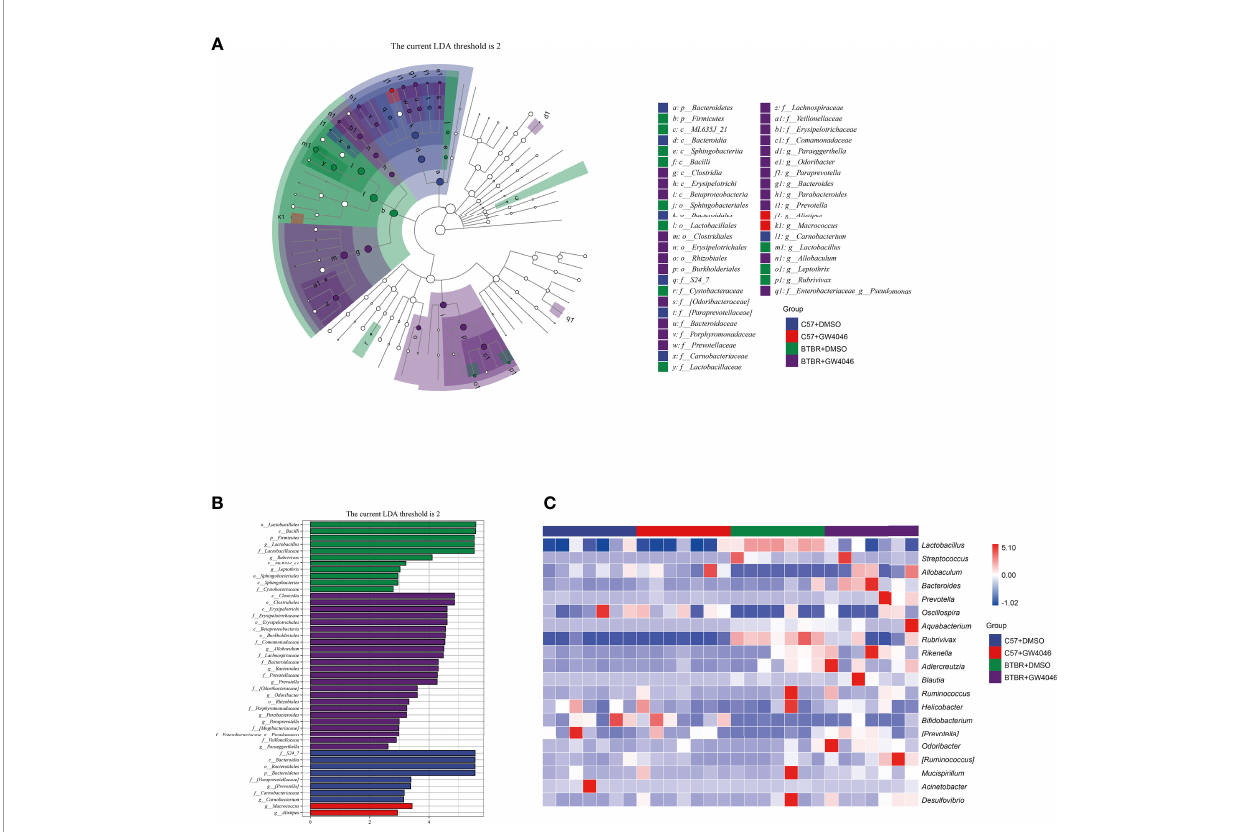
FIGURE 6 | Differential taxa abundance in the gut microbiota. (A) LEfSe analysis of gut microbiota in mice, depicting the taxonomic association between microbiota communities among the four groups. Each node represents a speci fi c taxonomic type. White nodes denote the taxonomic features that are not signi fi cantly differentiated. Blue, red, green, and purple nodes respectively denote the taxonomic types with more abundance than in other groups. The larger the diameter of the nodes, the more signi fi cant the difference. (B) The histogram of LDA value distribution and the evolutionary branch diagram of LEfSe analysis show the species whose LDA Score is higher than the set value (LDA score >2, P < 0.05). The histogram ’ s length represents the impact size of different species (LDA Score), and different colors represent the species in different groups (blue:C57+DMSO; red:C57+GW4064; green:BTBR+DMSO; purple:BTBR+GW4064). (C) Heatmap of selected most differentially abundant features at the genus level. The blue color represents less abundant, the white color represents intermediate abundance and red represents the most abundant. n =